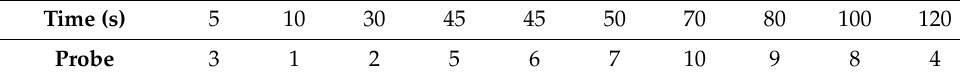
Figure 3. Temperature measurement at selected points in non-isothermal water model (Q = 2000 l/h, H = 0.4 m, ΔT = 30 °C). Table 3. Breakthrough time of different thermocouples. Table 3. Breakthrough time of different thermocouples.